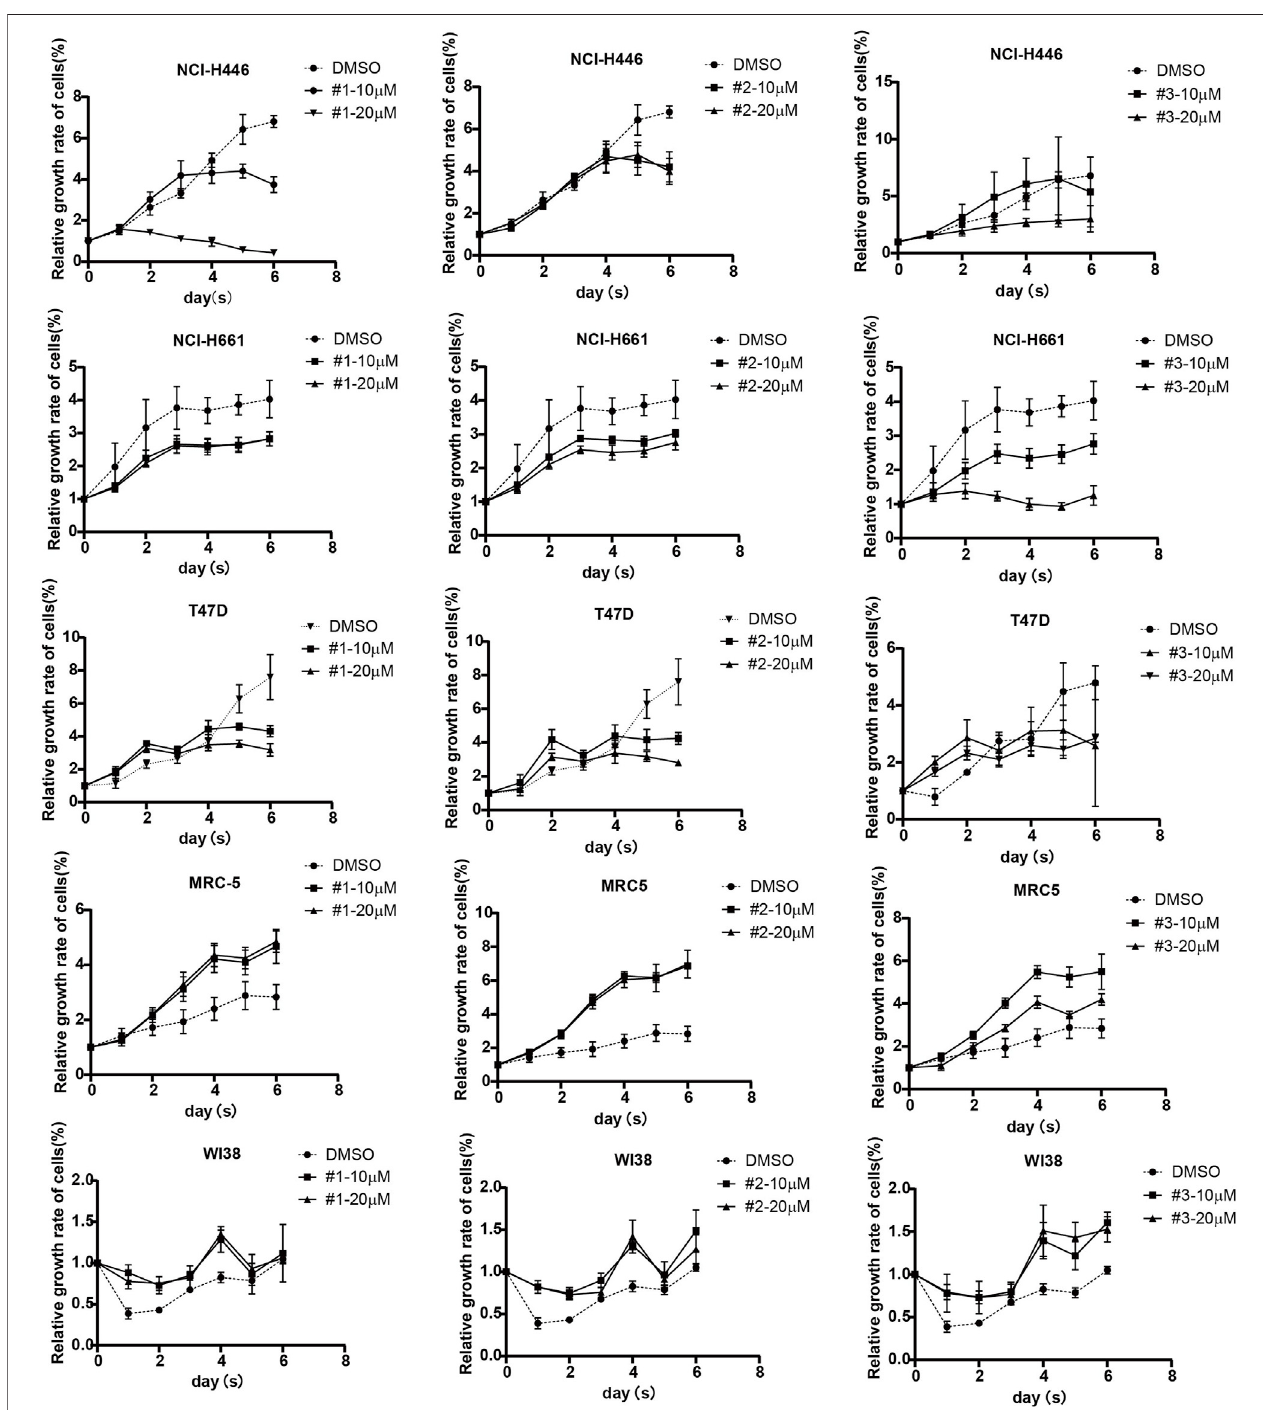
FIGURE 7 | The effects of the compounds on the proliferation of carcinoma cells. Three carcinoma cells including NCl-446, NCl-661 and T47D as well as MRC-5 and WI38 cell lines as twonegativecontrols were treated with compound #1, #2and #3 at the concentrationof10 μ M or 20 μ M or DMSO as a,cell viabilityis measured for a consecutive 6 days by a CCK8